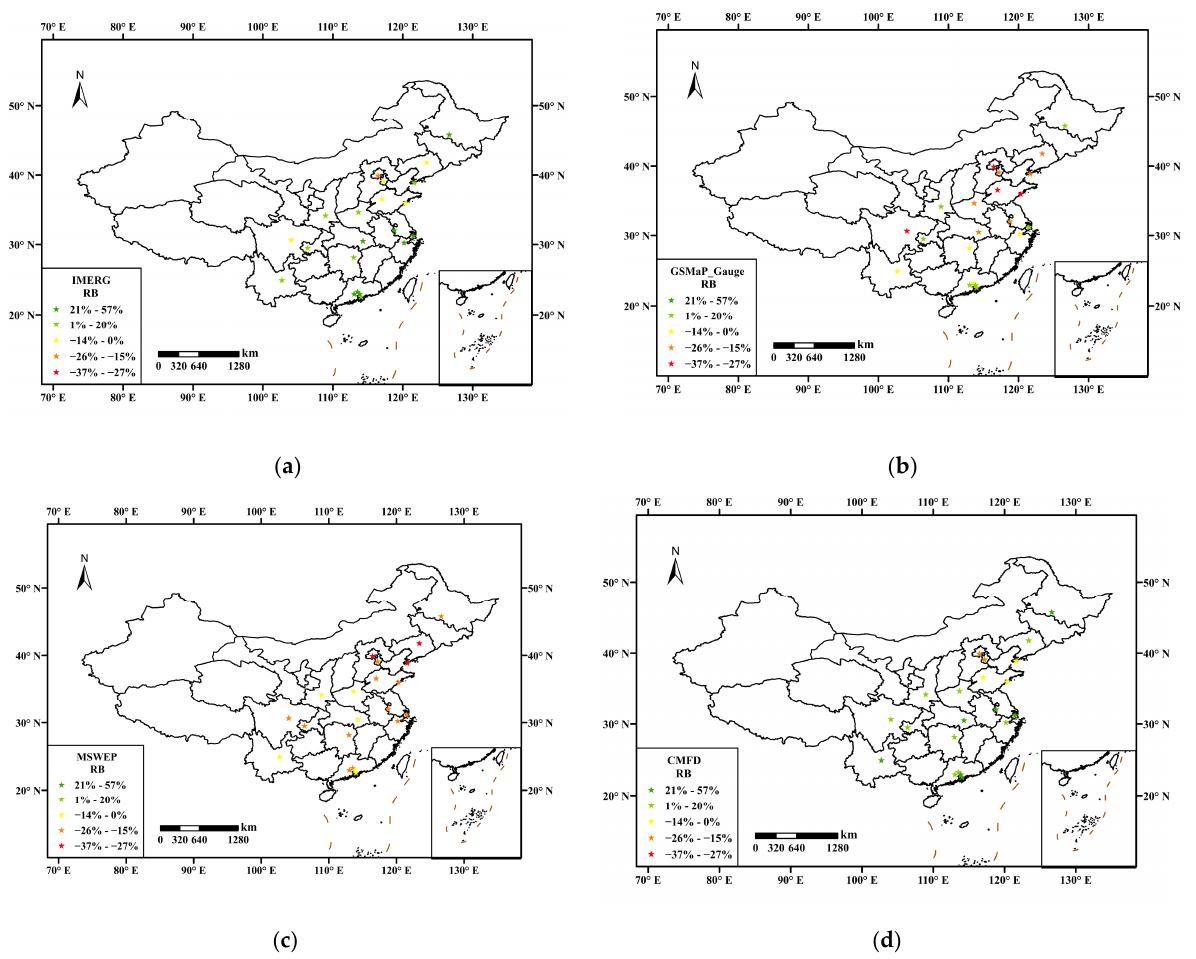
Figure 10. The relative bias between R99TOT values of SPPs data and rain gauges in 21 major cities: ( a ) IMERG, ( b ) GSMaP_Gauge, ( c ) MSWEP, and ( d ) CMFD.